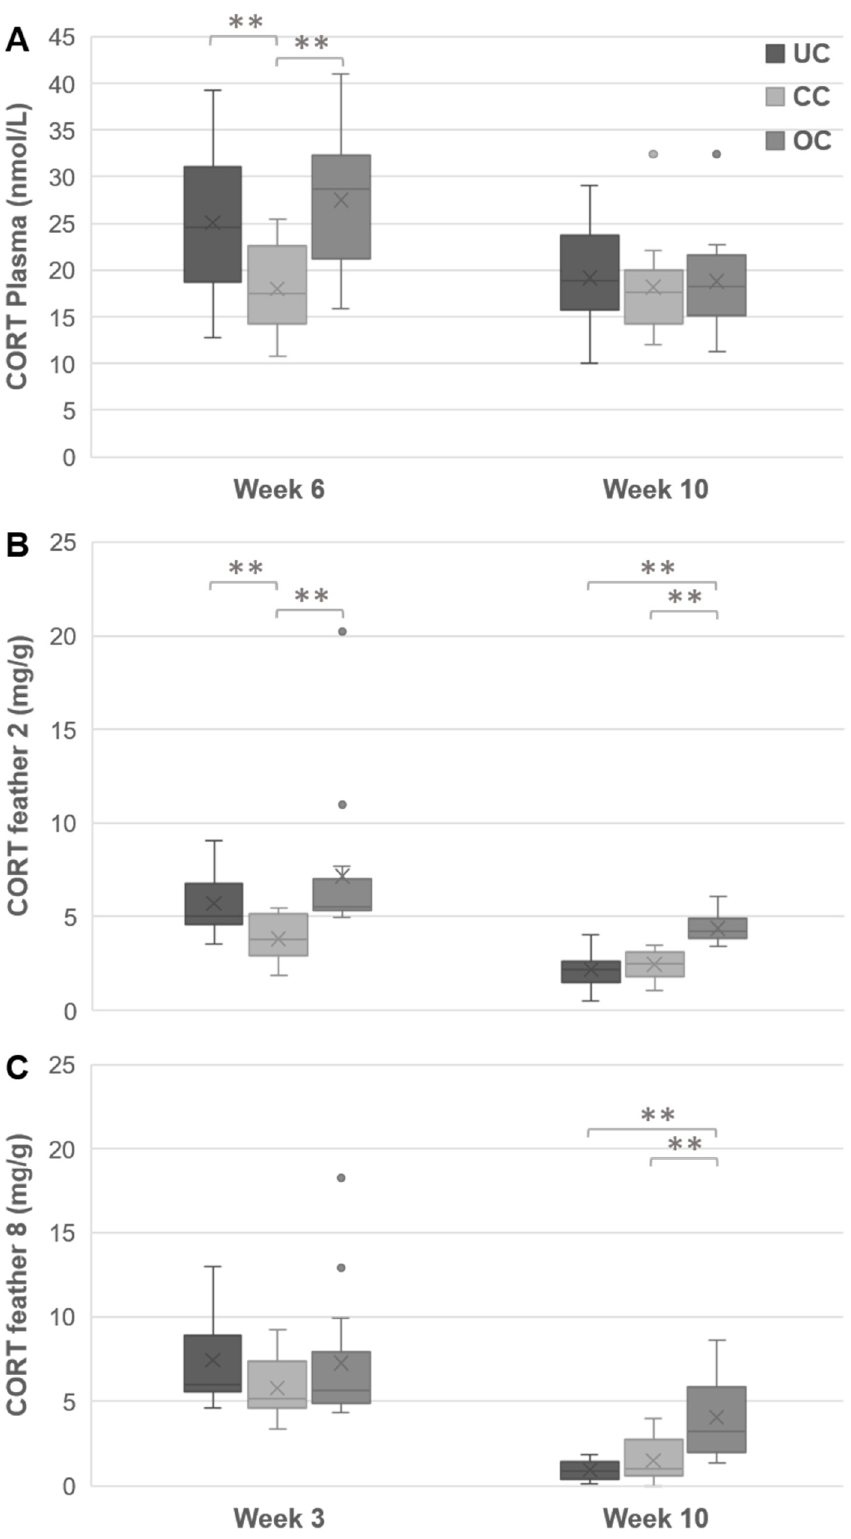
Figure 6. Effects of housing density on plasma CORT levels. The plasma CORT levels (nmol/L) in chicks aged 6 weeks and 10 weeks ( A ), CORT deposition (pg/mg) in feather 2 ( B ) and feather 8 ( C ) at 3 weeks and 10 weeks of age. The box ranges from the first to the third quartile, line indicates the median and cross indicates the mean, whiskers represent minimum and maximum without outliers, * p < 0.05, ** p < 0.01 (UC = undercrowding, CC = conventional crowding, OC = overcrowding condition).